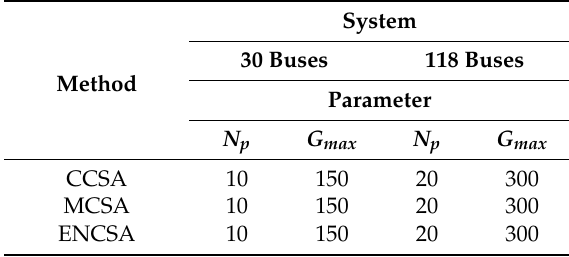
Table 3. Selection of control parameters for the applied